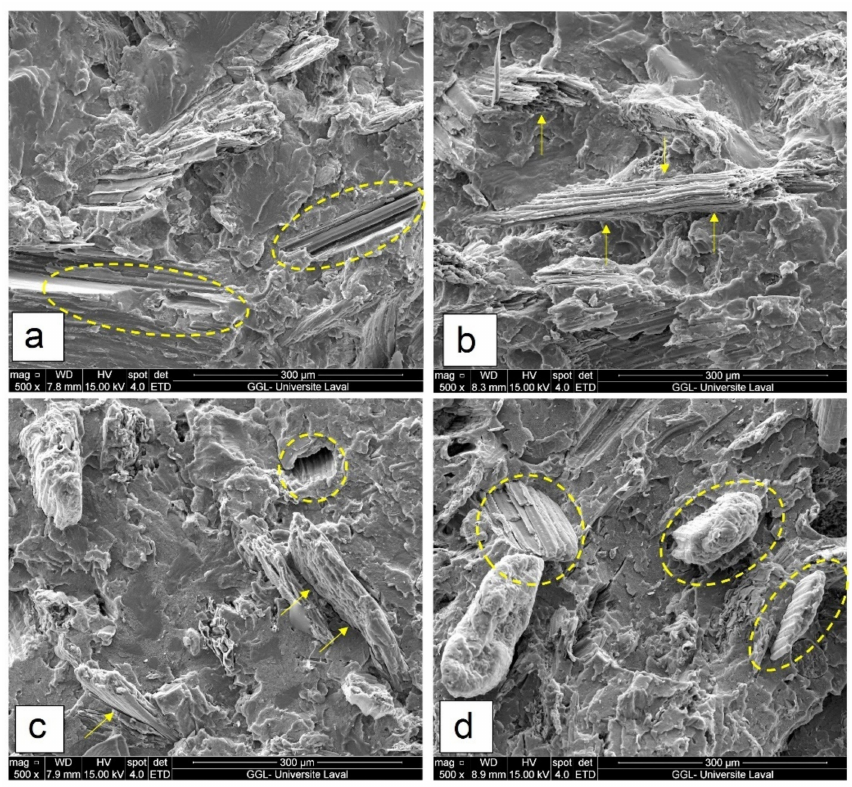
Figure 4. SEM micrographs of: ( a ) R40F* (CM), ( b ) R40F* (IM), ( c ) R55F* (CM) and ( d ) R55F* (IM) (see Table 1 for